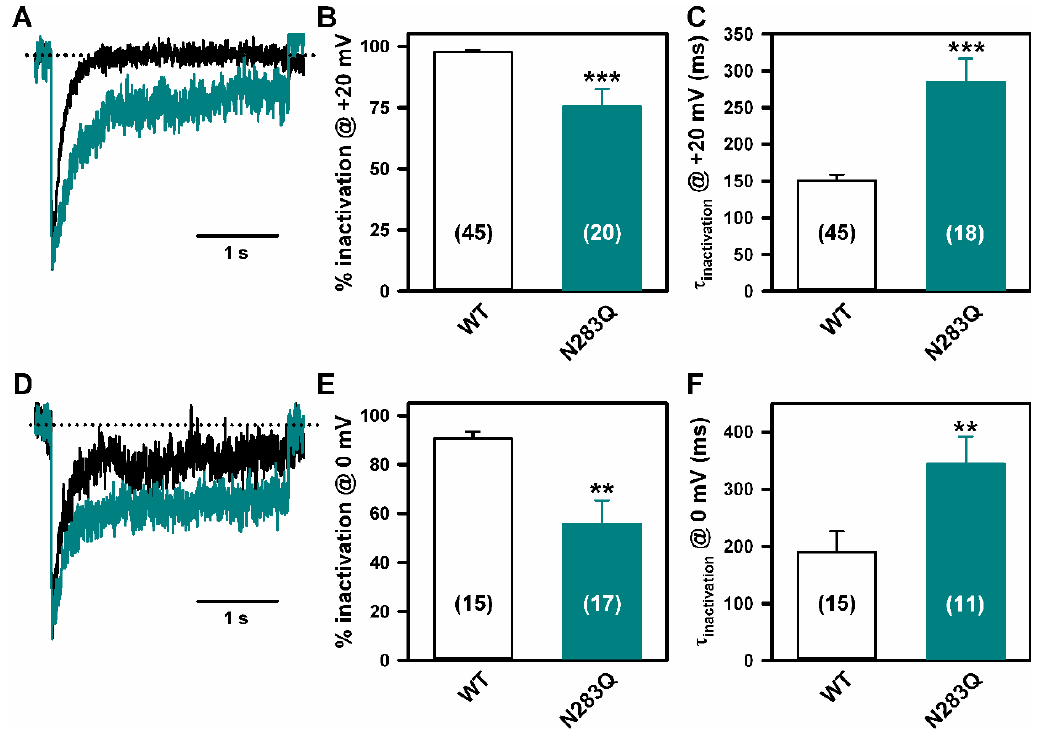
Figure 8. N283Q glycosylation site mutation lessens Ca V 2.1 channel inactivation. Ca 2+ current traces (normalized to the corresponding peak amplitude) illustrating differential inactivation of WT (black traces) and N283Q (cyan traces) Ca V 2.1 channels, in response to a 3 s depolarizing pulse to +20 mV ( A ) or 0 mV ( D ). Dotted lines indicate the zero current level. ( B , E ) Average Ca 2+ current inactivation (in %) at the end of these 3s depolarizing pulses obtained from HEK293 cells expressing either WT or N283Q Ca V 2.1 channels. Data are expressed as the mean ± SEM of the number of experiments shown in brackets (*** p < 0.001 and ** p < 0.01 versus WT, Mann-Whitney U -test). ( C , F ) Average τ inactivation values of Ca 2+ currents through WT (open bars) and N283Q (cyan bars) Ca V 2.1 channels expressed in HEK293 cells, elicited by a 3 s depolarizing pulse to +20 mV or 0 mV, as indicated. Data are expressed as the mean ± SEM of the number of experiments shown in brackets (*** p < 0.001 and ** p < 0.01 versus WT, Mann-Whitney U -test).